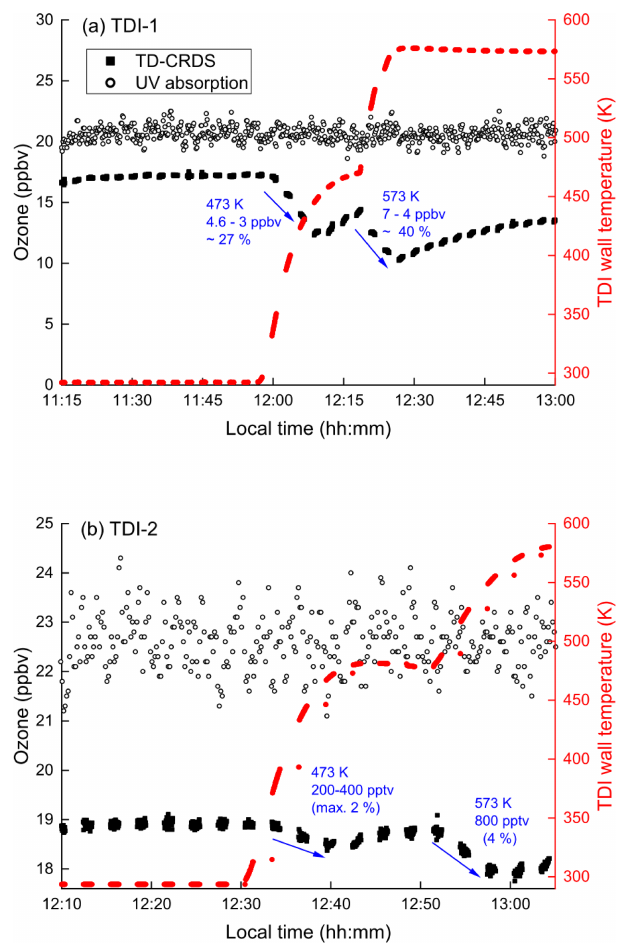
Figure 8. Time series of O 3 mixing ratios before and after passing though TDI-1 (a) or TDI-2 (b)